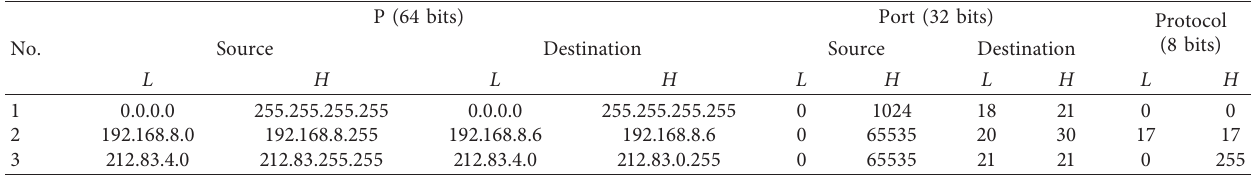
Table 2: Range representation of three rules.